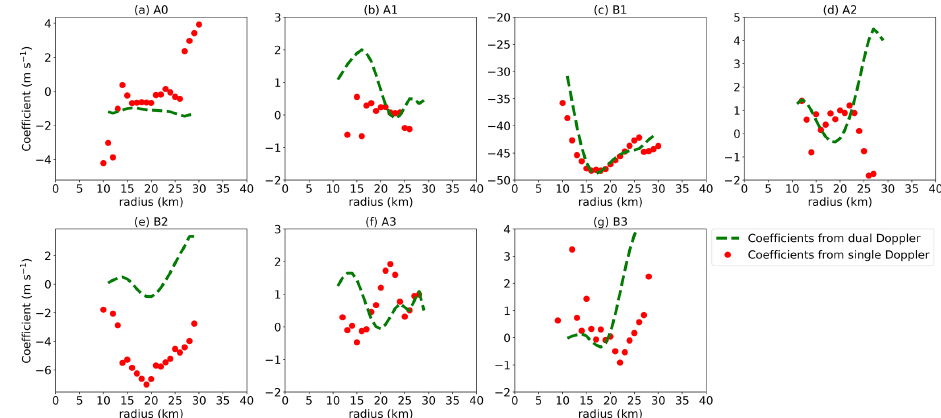
Figure 6. Comparison of V d D/R T harmonics coefficients derived from the resampled dual-Doppler winds synthesized from 18:55 to 19:40UTC using the improved GVTD technique (green dashed line), and the single-Doppler retrieval at 19:21UTC using the improved GVTD technique (red dot): (a) A 0 (to obtain V R C 0 and V M cos (θ T − θ M ) ); (b) A 1 (to obtain V R C 0 ); (c) B 1 (to obtain V T C 0 ); (d) A 2 (to obtain V R C 0 and V T S 1 ); (e) B 2 (to obtain V T C 1 ); (f) A 3 (to obtain V R C 0 and V T S 2 ); (g) B 3 (to obtain V T C 0 and V T C 2